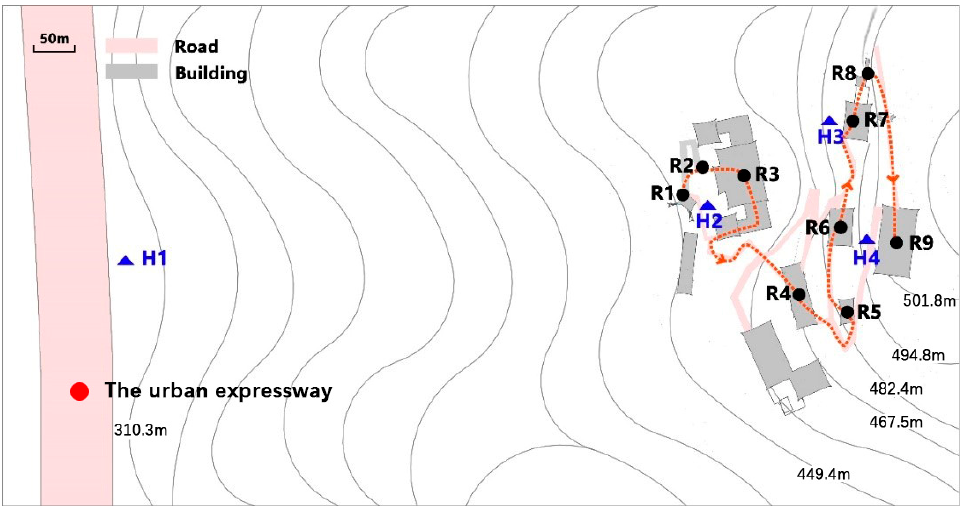
Figure 3. The layout of 24-h sound level measurement points including H1: The urban